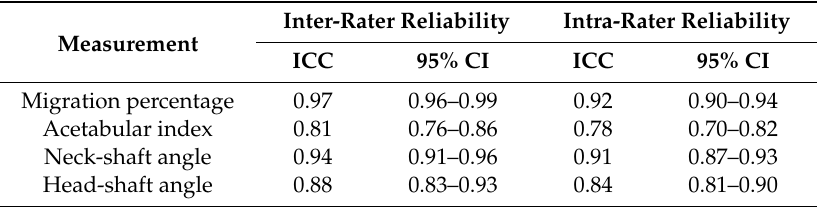
Table 1. Inter-rater and intra-rater reliabilities of the radiographic measurements.